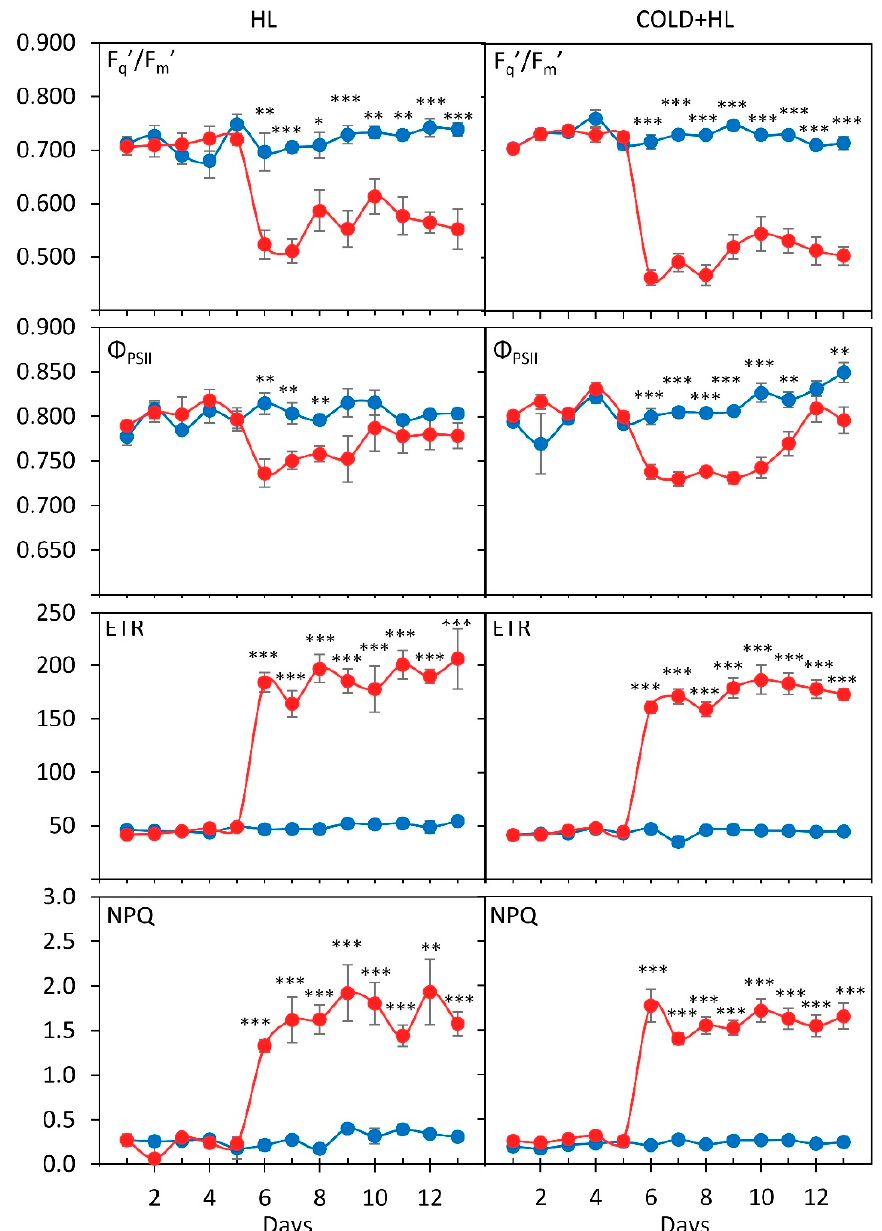
Figure 1. Operating efficiency PS II (F q ′ /F m ′ ), maximum efficiency PS II ( Φ PSII , F v /F m ), electron transfer rate (ETR), and non-photochemical quenching (NPQ) of GL of P. zonale plants during a five-day pretreatment (LL) and an eight-day exposure to low light (LL, 180 µmol m –2 s –1 , blue line) and to high light (HL, 800 µmol m –2 s –1 , red line) in the HL (25 °C; left) and Cold + HL (18 °C; right) experiments. Values represent means ± SE ( HL : n = 10; Cold + HL : n = 22). Significant differences between plants treated with LL and HL, according to the t -test, are indicated in each experiment (* p < 0.05; ** p < 0.01; *** p < 0.001).